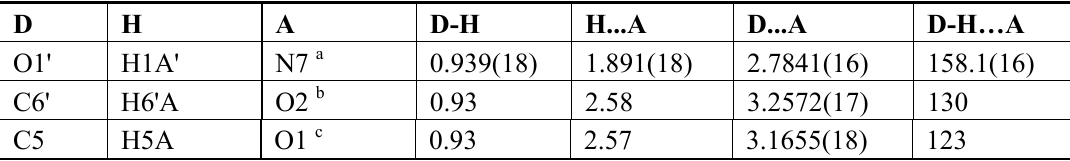
Table 5. Hydrogen bonding data for compound 15